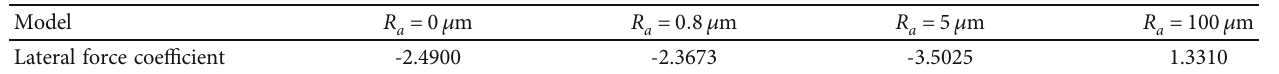
Figure 32: Comparison of leeward pressure at the middle and body tail with di ff erent roughness values: (a) Model 1, (b) Model 2, (c) Model 3, and (d) Model 4. Table 8: Lateral force coe ffi cient for 4 kinds of